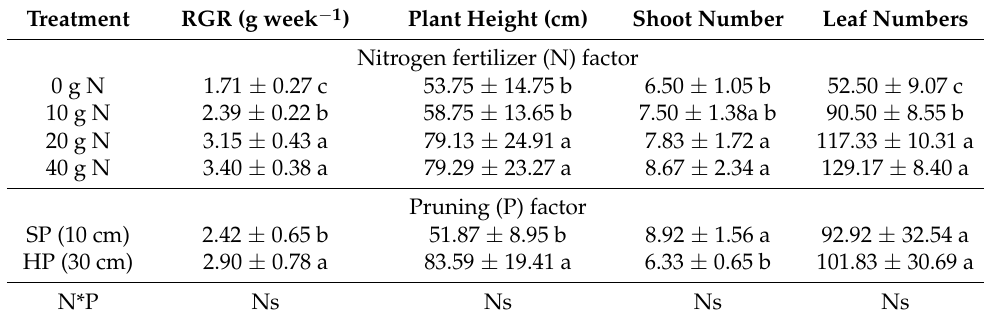
Table 2. Kaffir lime growth performance under different pruning levels and nitrogen-fertilizer dosages. Treatment RGR (g week − 1 ) Plant Height (cm) Shoot Number Leaf Numbers Nitrogen fertilizer (N)